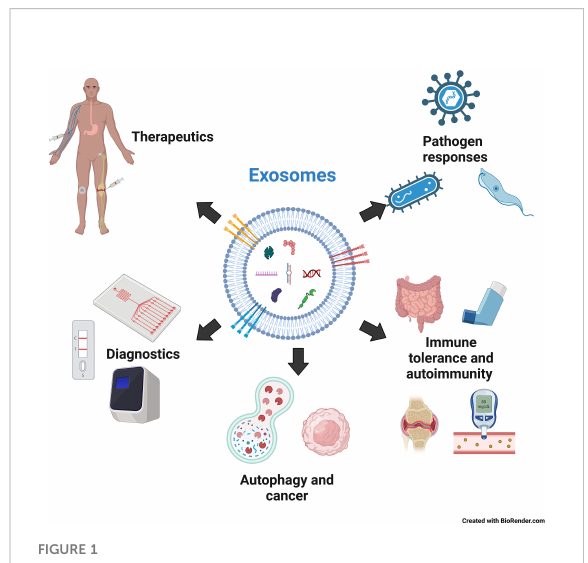
FIGURE 1 The role of exosomes in innate immunity, diagnosis and therapy. Created with